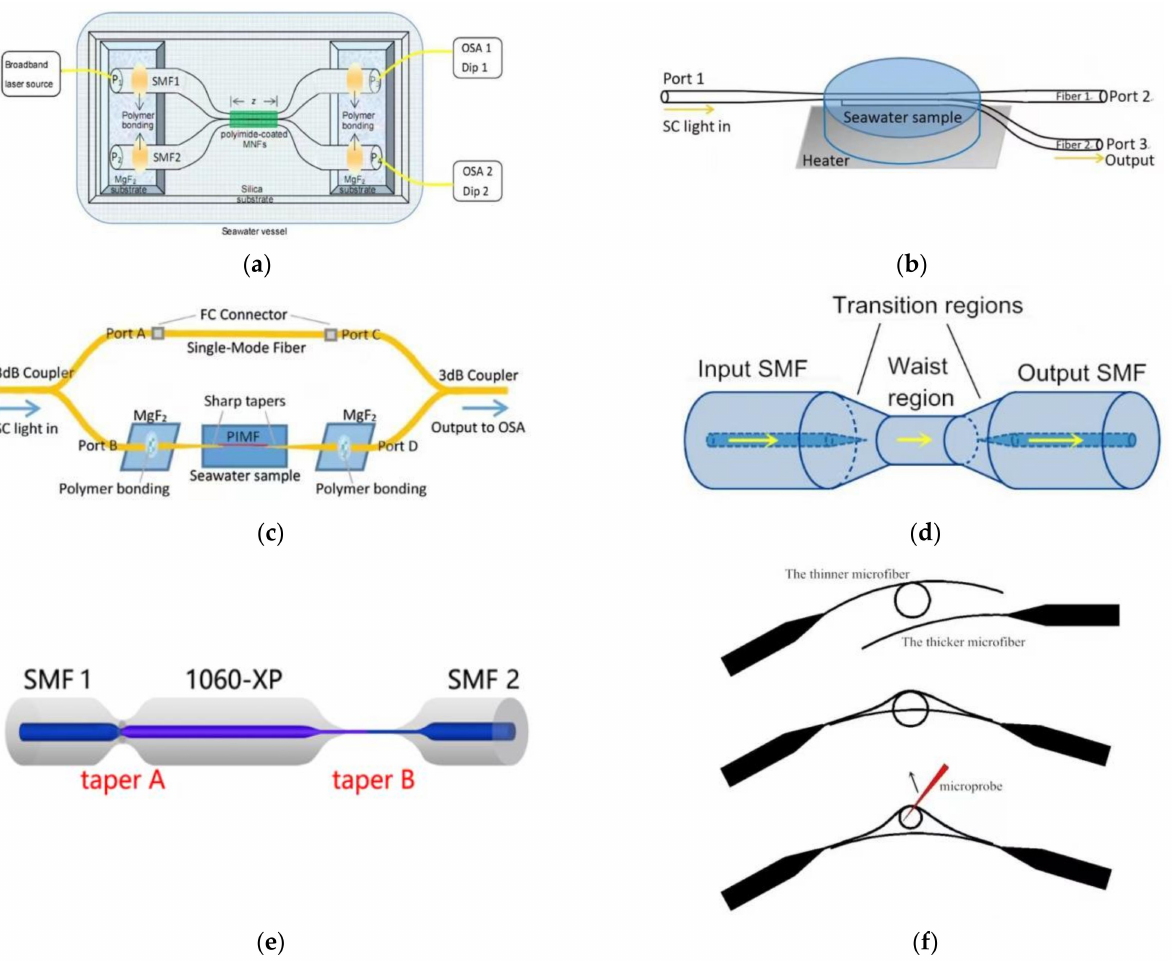
Figure 4. Schematic diagram of ( a ) the sensor [98] and ( b ) experiment setup [99] for the measurement of TS in seawater by OMC. ( c ) Schematic diagram of the hybrid MZI [102]. ( d ) Schematic diagrams of tapered fiber structure [103]. ( e ) Combining the in-line MMZI with tapered SF or Sagnac loop [104]. ( f ) The fabrication process of a microfiber MZ interferometer with a knot resonator structure [106]. Reprinted with permission from Ref. [106]. Copyright 2016